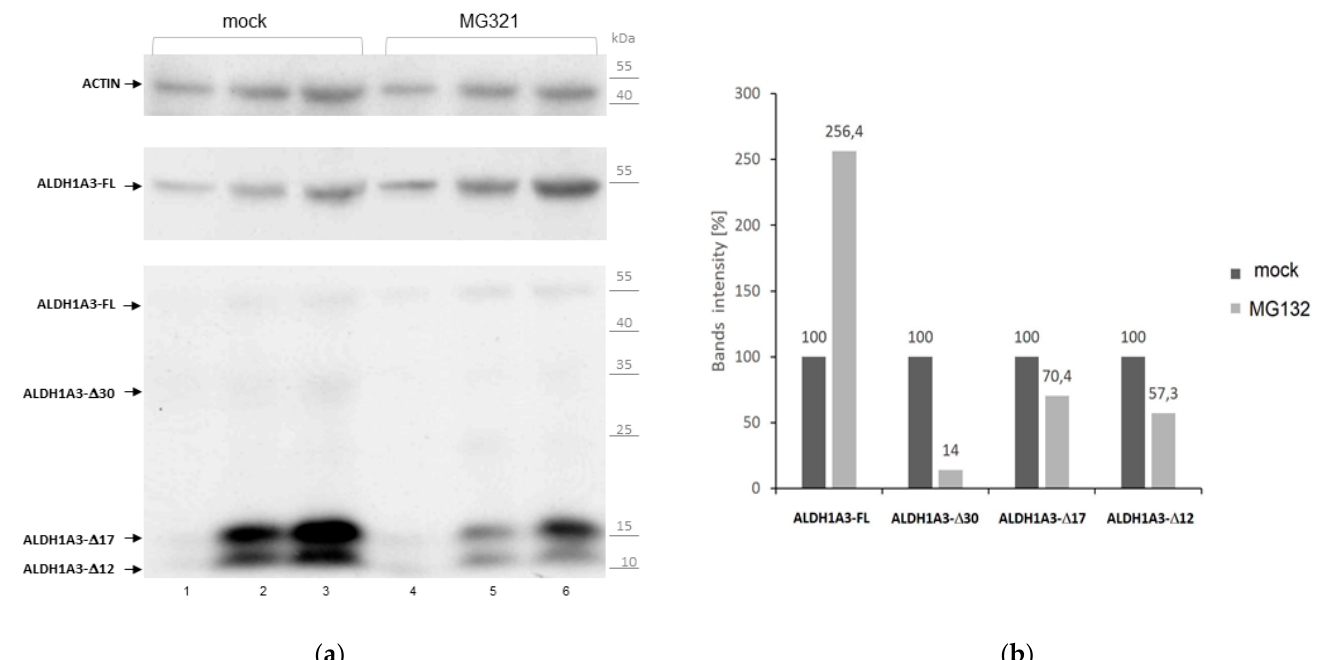
Figure 7. Effects of proteasome inhibition by MG132 on the steady-state levels of ALDH1A3-FL and its truncated variants. ( a ) Western blot assessments of whole lysates of GSC#726/R1 cells treated with MG132 or DMSO (mock control). Increasing protein amounts (40, 60 and 80 µg per well) were loaded in lanes 1&4, 2&5 and 3&6, respectively. After probing with ALDH1A3 antibodies, the membrane was stripped and probed for actin. ( b ) Graphical presentation of the normalized data. The intensity of the bands corresponding to ALDH1A3-FL, ALDH1A3 ∆ 17 or ALDH1A3 ∆ 12 was quantified by densitometry and normalized to actin. The mock-treated control was set to 100 (black bars). Grey bars show the mean change in the abundance of ALDH1A3-FL, ALDH1A3 ∆ 17 or ALDH1A3 ∆ 12 after MG132 treatment compared to mock-treated control samples. Proteasome inhibition leads to a decrease in the abundance of truncated ALDH1A3 proteins and increase of the full-length ALDH1A3.